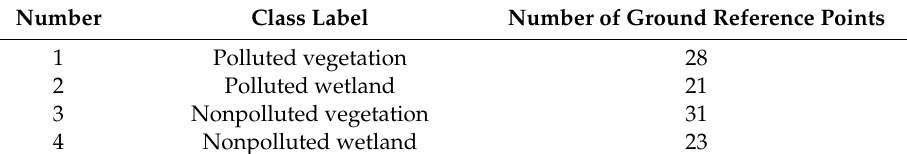
Table 1. Oil spill and non-oil-spill ground truth points.